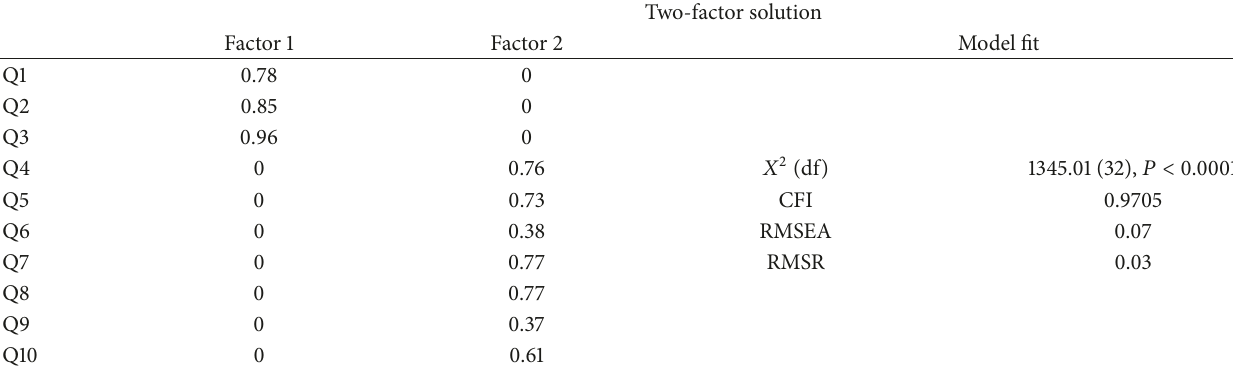
Table 1: Factor loadings for confirmatory factor analysis of AUDIT.